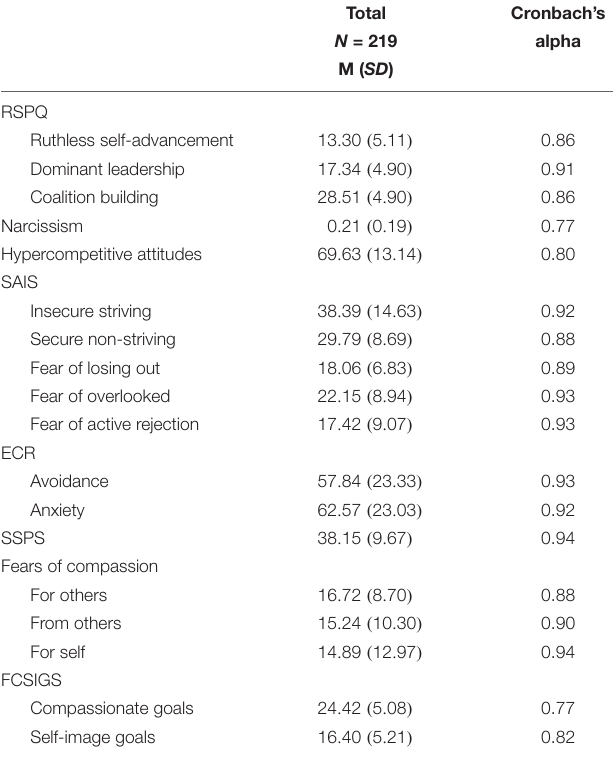
TABLE 1 | Means and standard deviation of all study